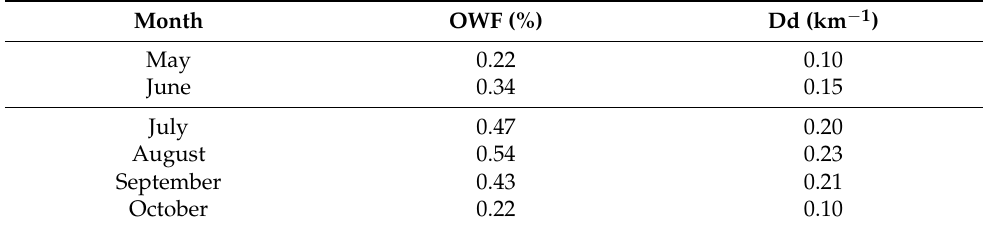
Table 5. Mean values of OWF and Dd from 2017 to